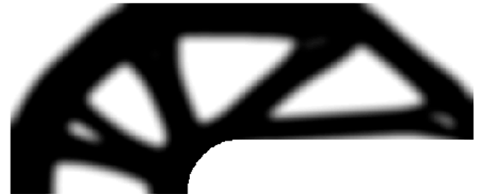
Figure 30. The final topology obtained using [35].